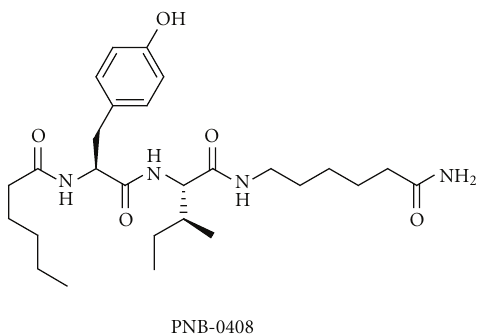
Figure 8: The structure of the compound PNB-0408, which crosses the blood-brain